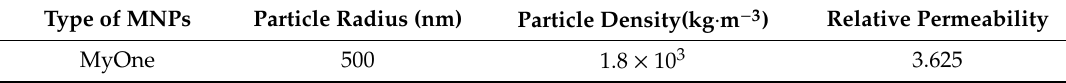
Table 1. Parameters of selected magnetic nanoparticles (MNPs)